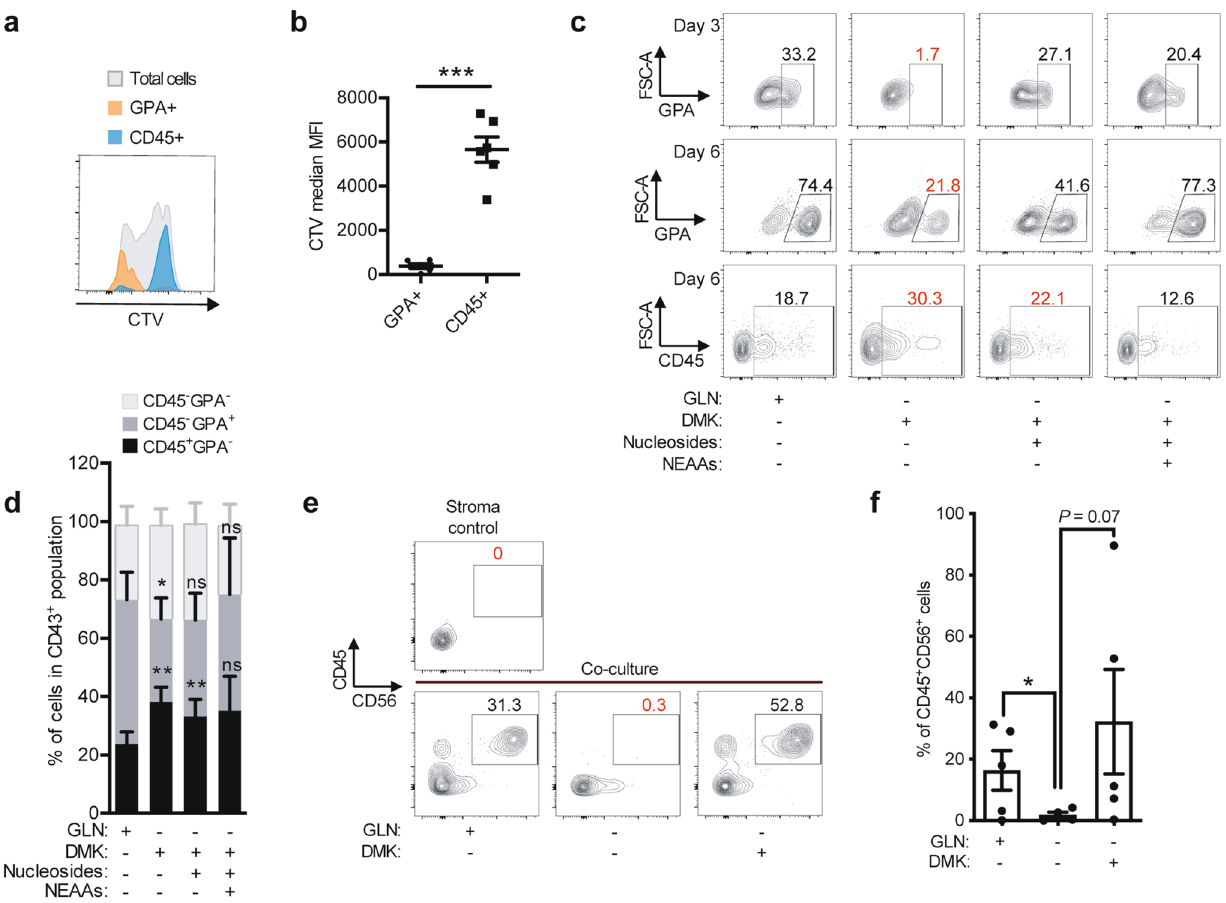
Figure 3. Glutamine differentially contributes to the formation of GPA + and CD45 + cells during EHT. ( a ) Representative day 3 CellTrace Violet (CTV) plot is shown for GPA + (in orange) and CD45 + (in blue) populations deriving from HE cells. ( b ) CTV median MFIs ± s.e.m. corresponding to ( a ) are shown (n = 6, paired t -tests). ( c , d ) FACS-sorted HE cells were subcultured in glutamine-free medium with the indicated compounds: DMK (1.75 mM), Nucleosides or NEAAs. ( c ) Subculture day 3 or day 6 representative plots, gated on the CD43 + population, are shown for FSC-A / GPA and FSC-A/CD45. ( d ) Percentages of cells expressing GPA or CD45 in the CD43 + population ± s.e.m. at day 6 of subculture are depicted (Control, n = 7; DMK, n = 6; DMK + nucleosides, n = 5; DMK + nucleosides + NEAAs, n = 3; paired t -tests with the controls). ( e , f ) FACS- sorted HE cells were subcultured in glutamine-free medium with or without DMK (1.75 mM) for 3 days, after which the treatment was removed and the cells were co-cultured with OP9-DL1 stroma for 35 days to induce NK cell differentiation. ( e ) Plots showing percentages of CD45 + CD56 + (NK) cells obtained at day 35. ( f ) Percentages of CD45 + CD56 + ± s.e.m. cells obtained at day 35 (Control and DMK, n = 5; −GLN, n = 4). ns, not significant, * p < 0.05, ** p < 0.01, *** p <